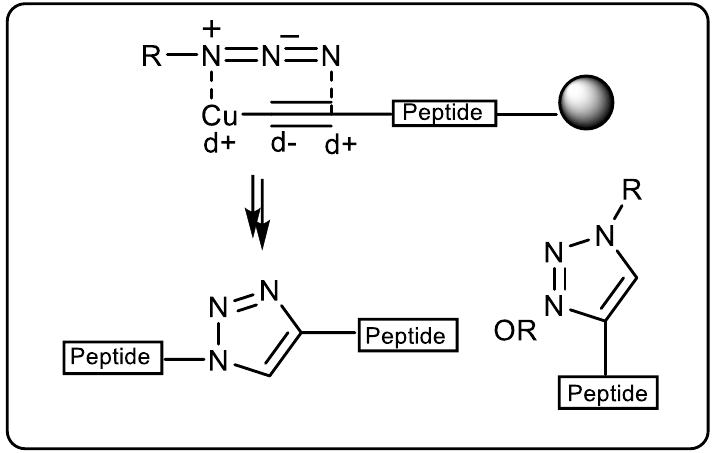
Figure 4. Copper(I)-catalyzed 1,3-dipolar cycloaddition of alkynes to azides affording peptidotria- zoles or N -substituted histidine analogs.